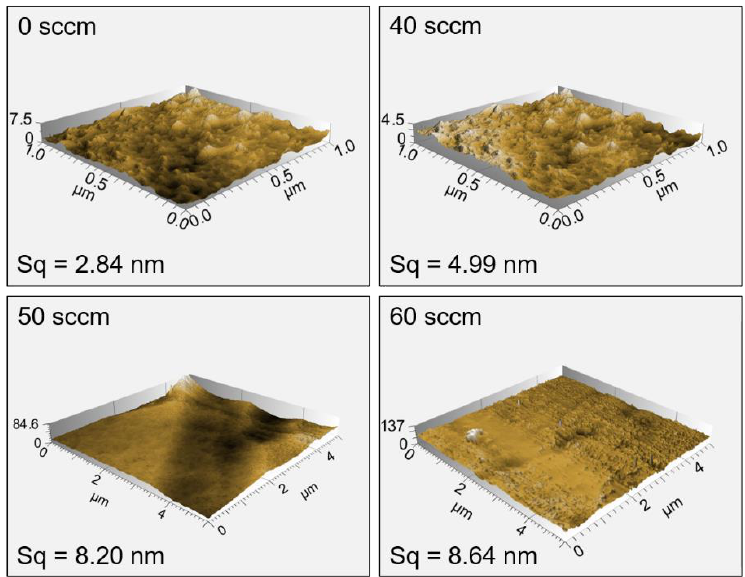
Figure 5. The roughness of the TiAlN coatings. Sq is the square roughness measured by